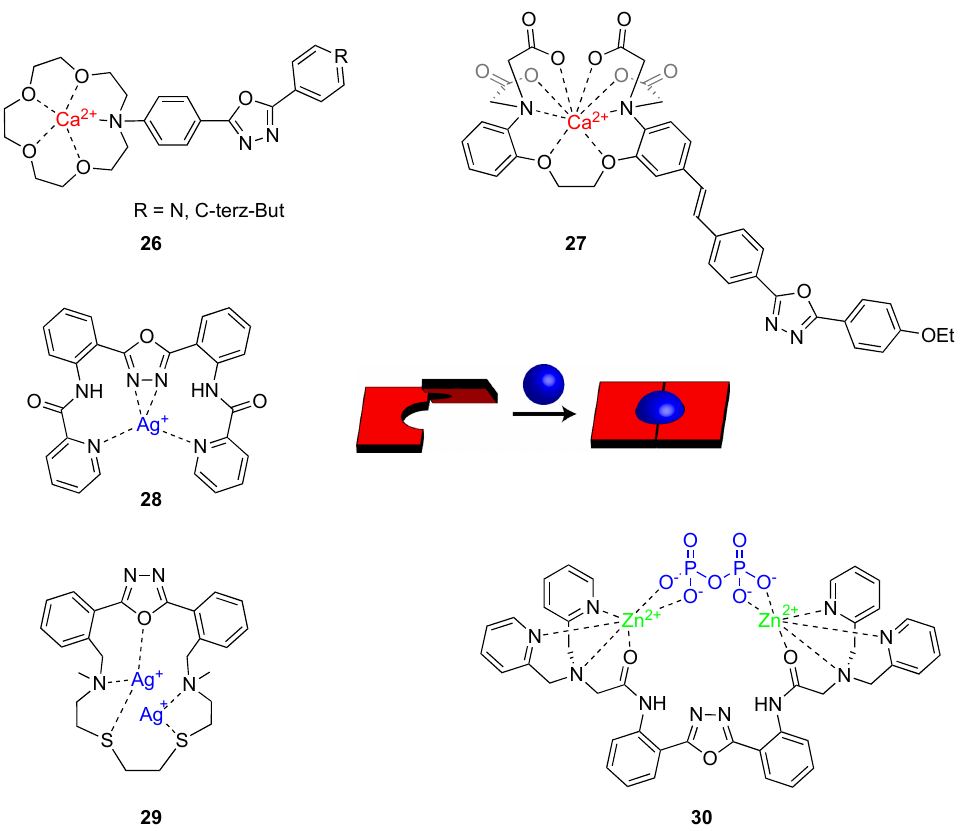
Figure 12. Structures of reported metal ion sensors bearing 1,3,4-oxadiazole units.